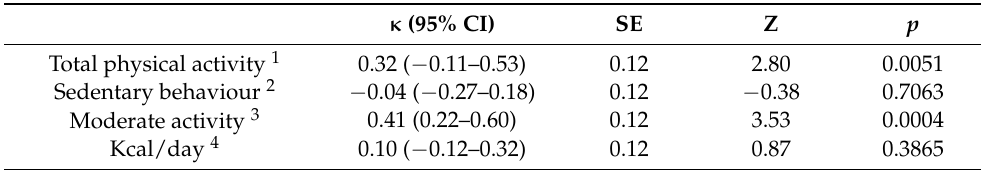
Table 6. Kappa ( κ ) coefficients between the tertiles of the objective and subjective method for measure physical activity in the total study